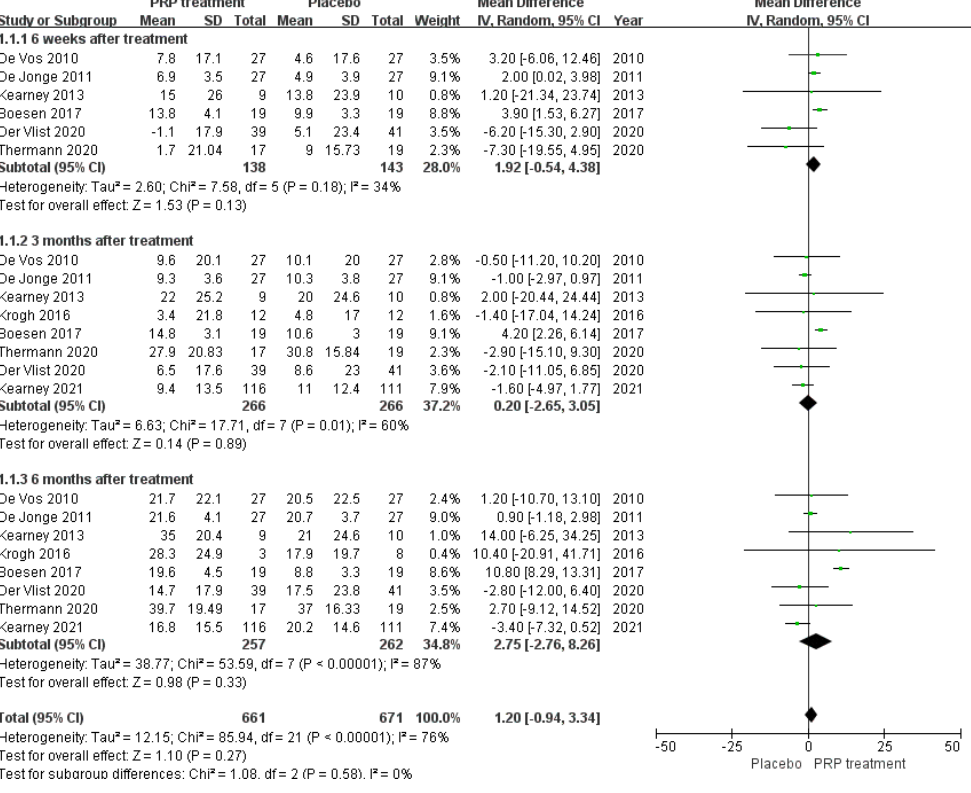
Figure 5. Forest plot of change values for the Victorian College Ankle Function Scale scores. Changes in Achilles Tendon Thickness A total of 98 patients in three publications correctly and reasonably described changes in Achilles tendon thickness. There was statistical heterogeneity between studies (I2 = 61%, p = 0.08), so a random effects model was used to calculate the combined statistic, which showed that 12 weeks after treatment, Achilles tendon thickness was higher in the PRP-treated group (experimental group) than in the placebo group (control group) [MD = 0.34, 95% CI (−0.04, 0.71), p = 0.08] (Figure 6), but the difference was not statistically significant. Using the Revman 5.4 software to transform the fixed effects model and ran- dom effects model, the included studies were re-combined to calculate statistics, showing no difference between the PRP treatment group and the placebo group in the mean and 95% confidence intervals for change in Achilles tendon thickness. After excluding each study once individually, the combined effect sizes obtained from the new meta-analysis were not significantly different from the total effect sizes. The above sensitivity analyses showed that the meta-analysis results were robust and reliable. Figure 6. Forest plot of Achilles tendon thickness variation.